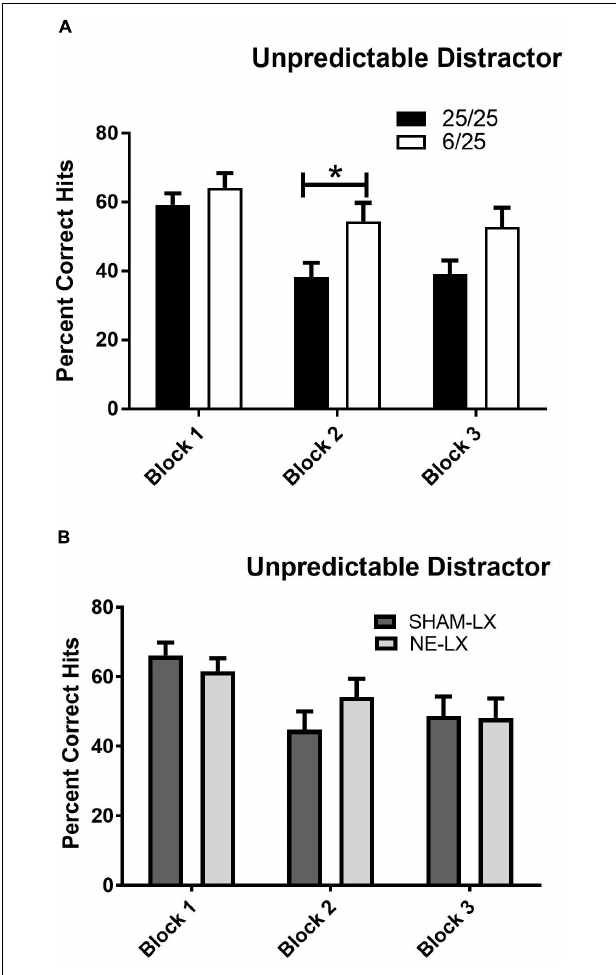
FIGURE 5 | (A) 25/25 rats (black bars) were more impaired than 6/25 (white bars) at discriminating visual target stimuli from the unpredictable distractor (0.25, 0.5, 1.0, 1.5, 2.0, or 3.0 s on/off) during the second block of testing. While 6/25 rats were better able than 25/25 rats to maintain signal detection in the presence of this distractor, both groups of rats were impaired when performance in this session was compared to performance in the prior day’s SAT performance as reported in the results. For comparison, see data in Figure 3B . (B) Performance in the uSAT was unchanged by noradrenergic lesions with no differences found in the % hits of sham-lesioned (dark gray bars) and noradrenergically lesioned rats (light gray bars). ∗ indicates p < 0.05.